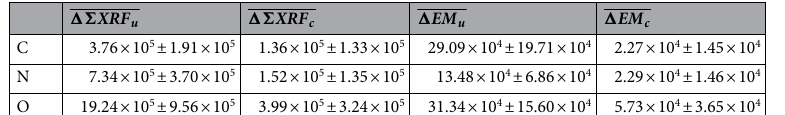
Table 1. Quantitative evaluation results. Results of the quantitative evaluation of the least squares differences of the correct and incorrect images, from the simulated images. Reported values represent average value ± standard